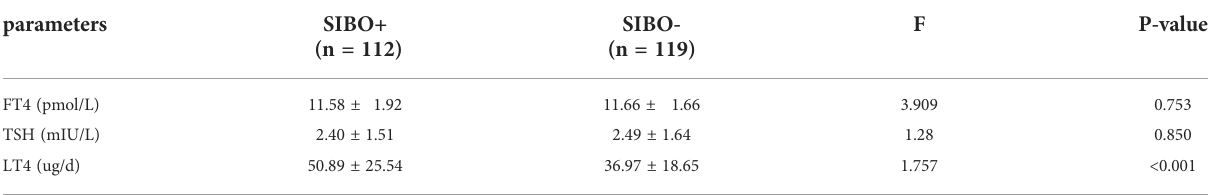
TABLE 4 Comparison of FT4, TSH levels and levothyroxine sodium tablets between SIBO positive and SIBO negative pregnant women with clinical hypothyroidism during pregnancy.